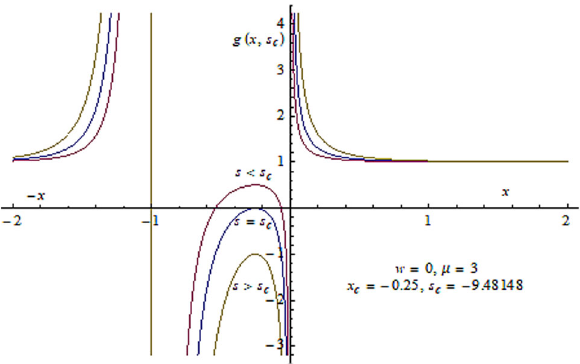
Fig. 8 Behavior of the new class of functions functions g ( x ; s ) for fixed values of the parameter s < s c and w = 0, μ = 3. The plot shows no black hole for positive values of x